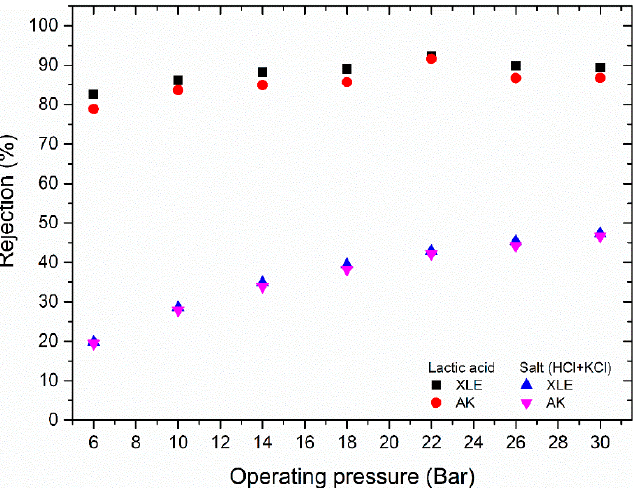
Figure 8. Lactic acid and salt rejection at a reduced feed solution pH of 2.3 as a function of operating pressure (operating temperature of 25 ◦ C, conductivity of 14 mS/cm and estimated composition of 1 g/L (11 mM) of lactate, 38 mM of Cl − , 33 mM of K + , and 5 mM of H + ). Conversely, as the acidity of the feed solution increased, the membranes will become more positively charged. This leads to greater transmission of chloride ions and in turn, a lower rejection of both HCl + KCl. Thus, at 6 bar transmembrane pressure, 80% of the salt (HCl + KCl) permeates, whereas 80% of the lactic acid is retained. With an 80% stage cut, the retentate composition would change to 4.2 g/L lactic acid and 0.5 g/L salt (HCl + KCl); after a second stage, this would be 17.6 g/L lactic acid and 0.9 g/L salt (HCl + KCl). How- ever, there would be a 30% loss of lactic acid into the permeate across the two stages.